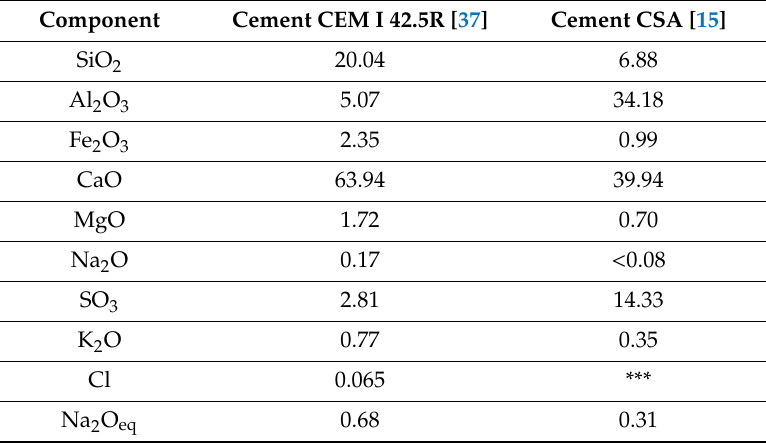
Table 1. Chemical composition of the cements.